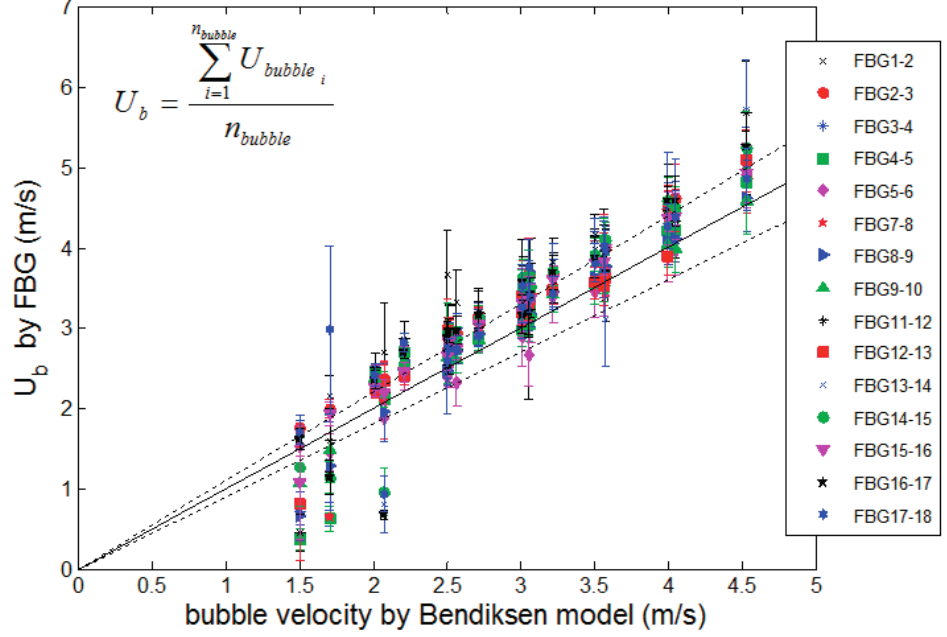
Figure 6. Bubble velocity measurement, using 18 fiber Bragg gratings